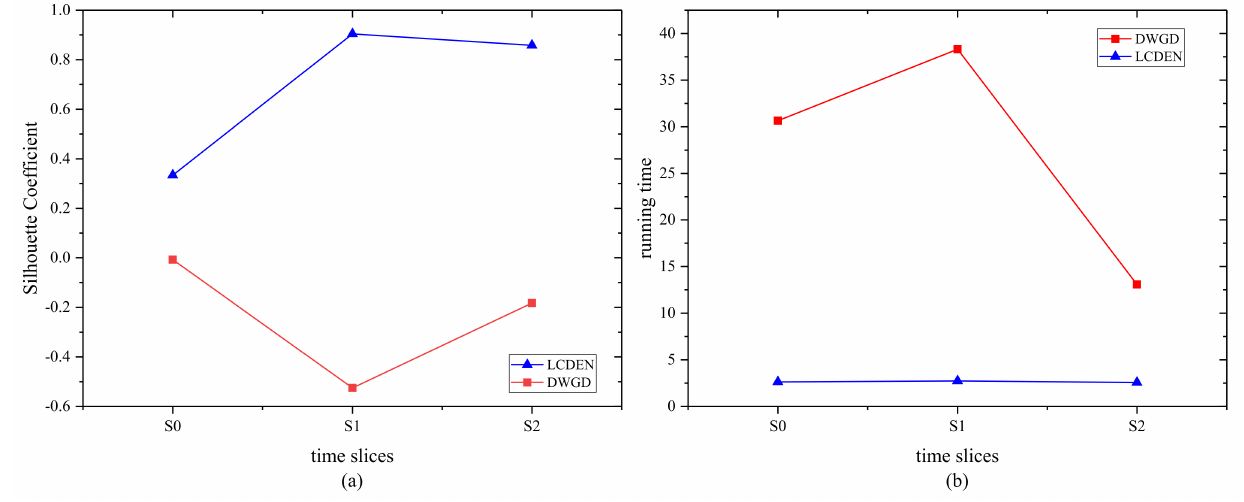
Figure 3. Comparison of the Silhouette Coefficient ( a ) and running time ( b ) on the Twitter